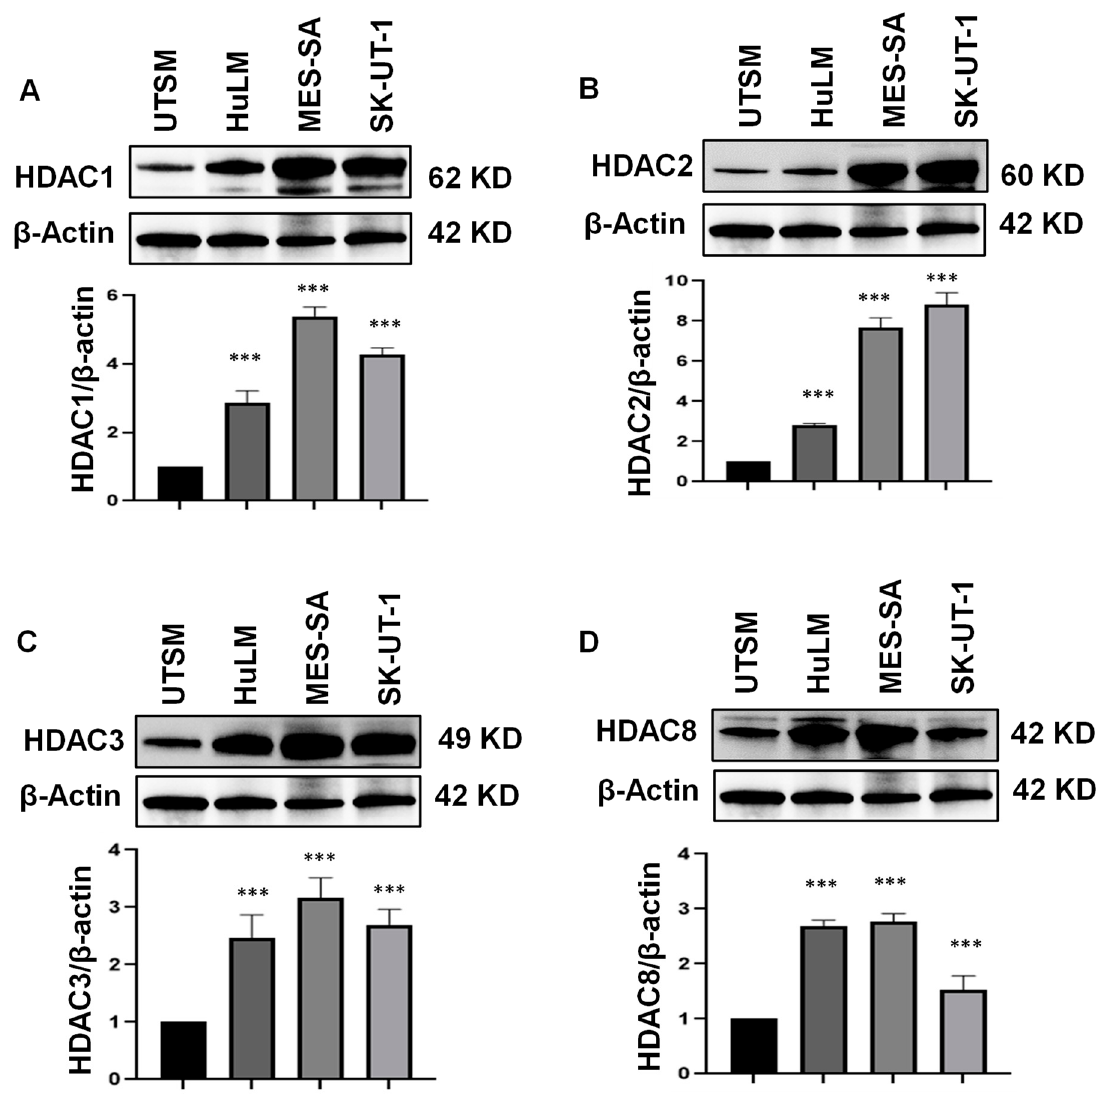
Figure 4. The expression of Class I HDACs in UTSM, HuLM, MES-SA, and SK-UT-1 cell lines . The protein levels of Class I HDACs (HDAC1 [( A ), 2 ( B ), 3 ( C ), and 8 ( D )] were measured by Western blot. β -actin was used as an endogenous control. Quantitative analysis of relative levels of HDAC1, 2, 3, and 8 ( A – D ) was performed using Image J (1.53t version) (NIH, Bethesda, MD, USA). *** p < 0.001.